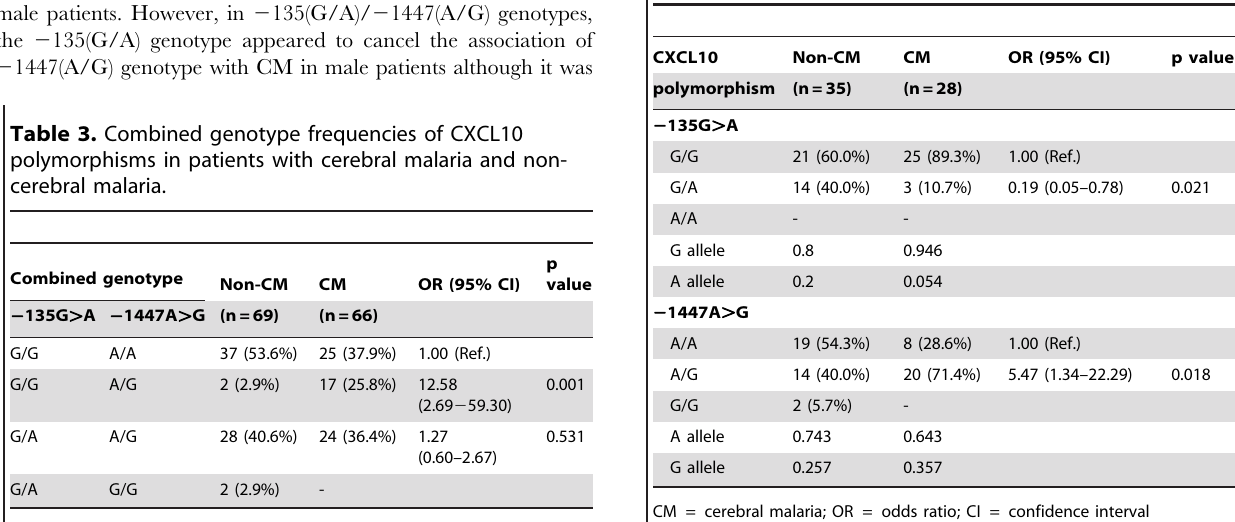
Table 4. Stratification analysis of male gender on association between CXCL10 promoter polymorphisms ( 2 135G . A